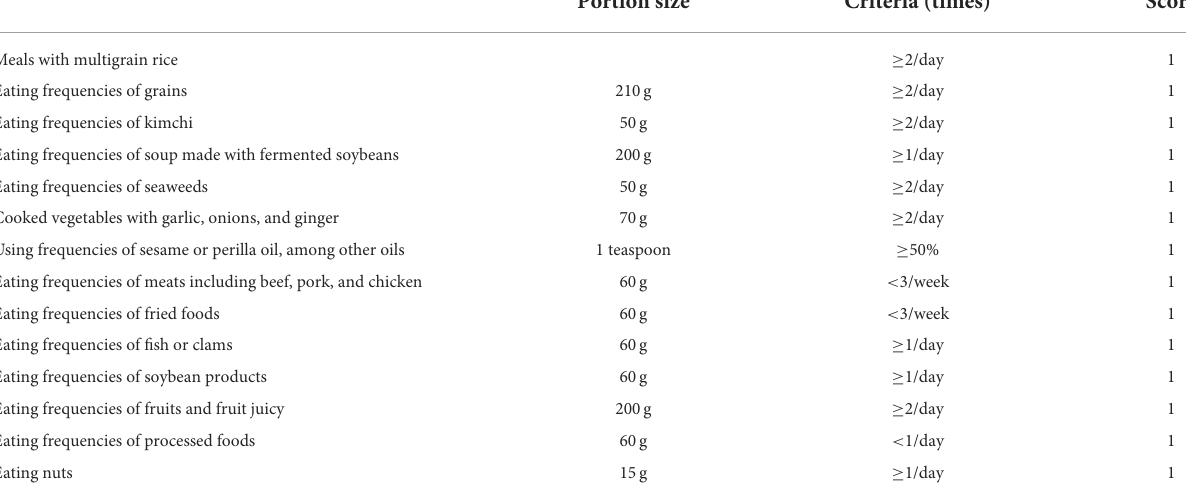
Portion size Criteria